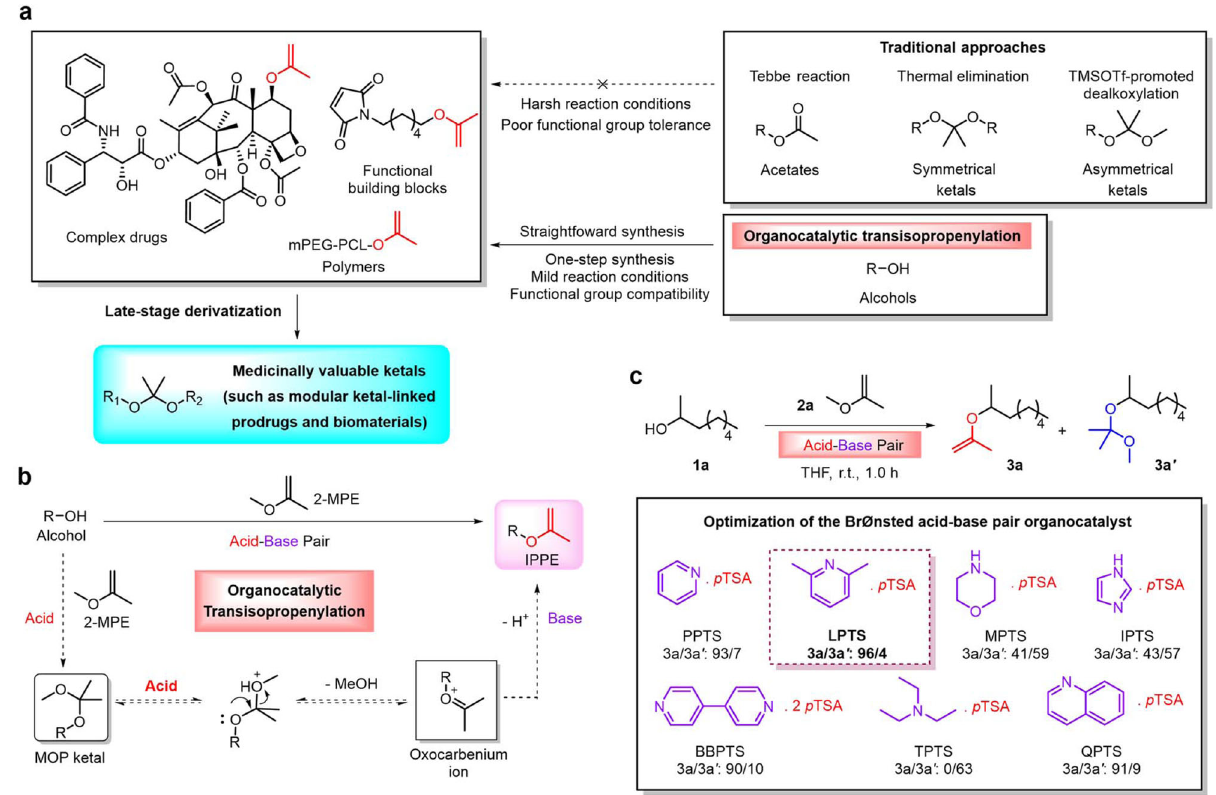
Fig. 1 Design of an organocatalytic transisopropenylation approach for the synthesis of IPPEs from alcohols. a Organocatalytic transisopropenylation enables the straightforward synthesis of IPPEs from hydroxyl-group-containing complex drugs (e.g., PTX), functional building blocks, and polymers under mild reaction conditions, complementing traditional approaches that are limited by the poor functional group compatibility and harsh reaction conditions. The resulting IPPEs will facilitate the synthesis of medicinally valuable ketals, such as modular ketal-linked prodrugs and biomaterials. b Organocatalytic transisopropenylation of alcohols, using 2-MPE with catalysis by Brønsted acid – base pair. Alcohol is transisopropenylated via the MOP ketal and transient oxocarbenium ion. c Optimization of the Brønsted acid – base pair organocatalyst. General conditions: 1a (1.0 mmol, 1.0 equiv., 0.5 M), 2a (16.0 equiv.), 0.5 mol % catalyst, THF, 25 °C, 1.0 h. The conversion rate of 1a and molar ratio of 3a to 3a ′ were determined by